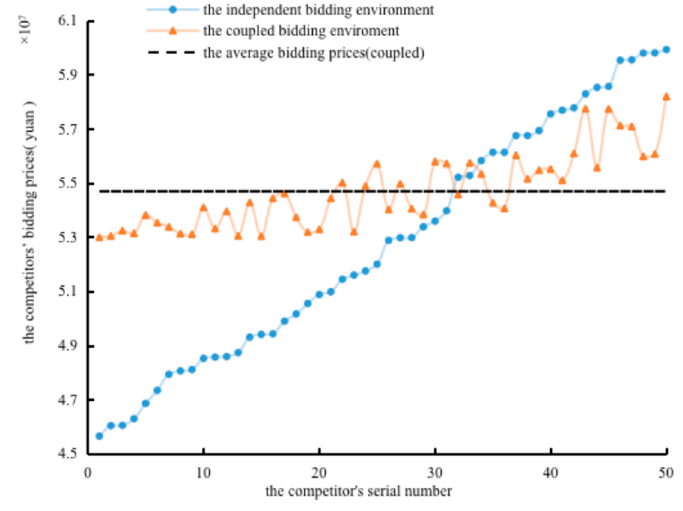
Figure 8. The bidding prices of competitors in independent and coupled bidding environments.